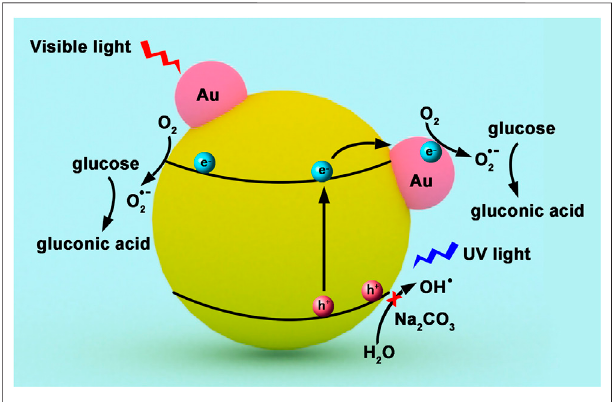
FIGURE 5 | Proposed mechanism for (A) visible light, and (B) UV light- induced glucose oxidation by Au/TiO 2 in aqueous Na 2 CO 3